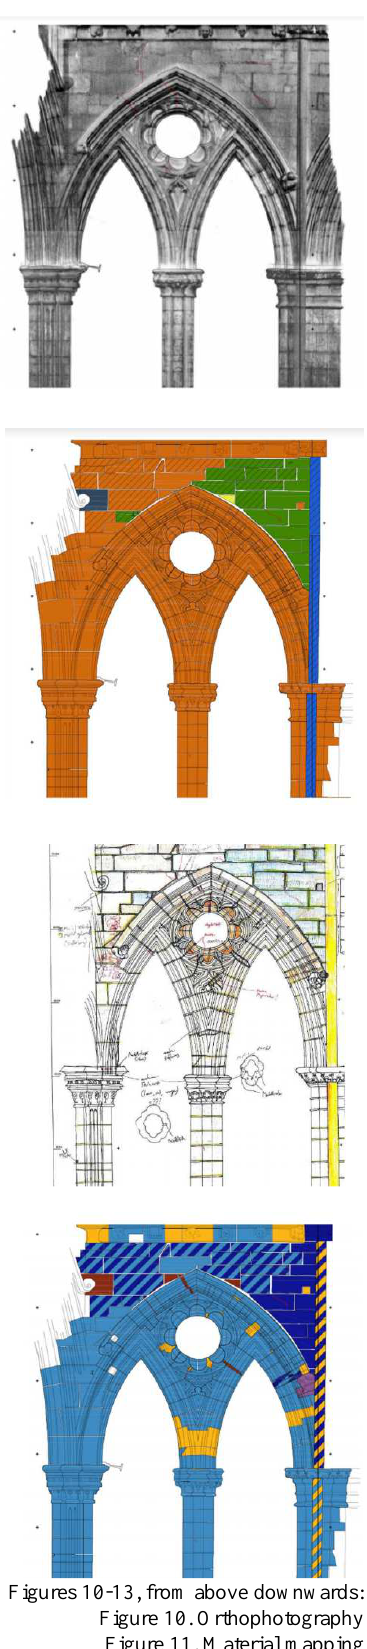
Figure 10. Orthophotography Figure 11. Material mapping Figure 12. Sketch on site of archaeological findings Figure 13. Construction phases (dark blue – before 1300; light blue – 1328 phase; red – 1510/23 phase; yellow – 1872/77 phase)